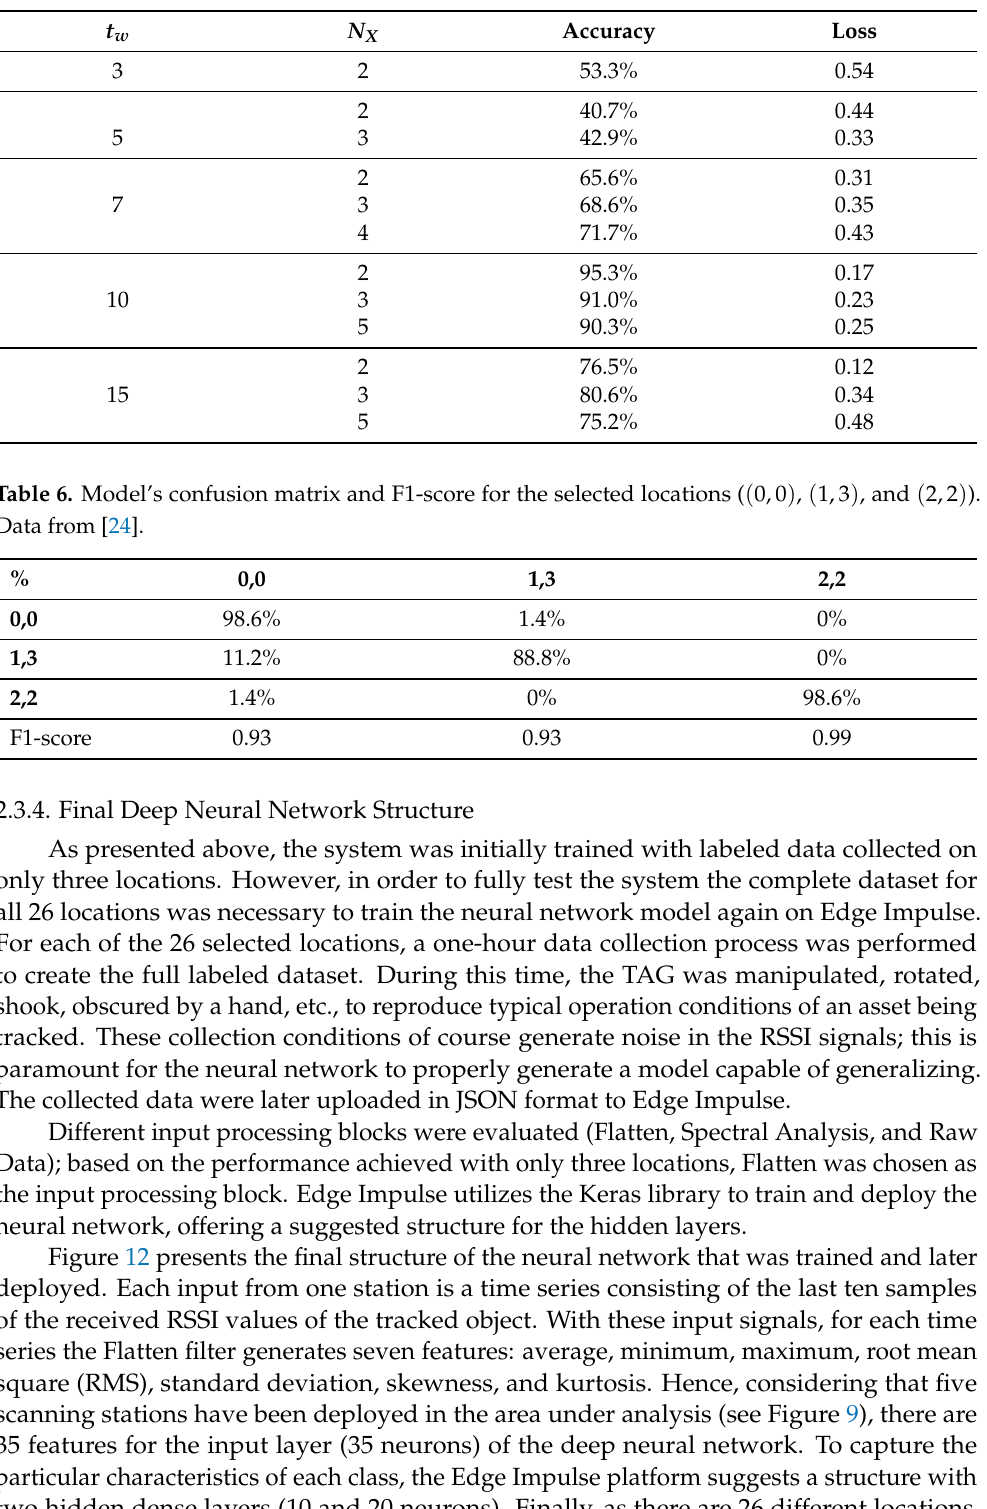
Table 5. Accuracy and loss in the model for different t w and N X (data from [24]).